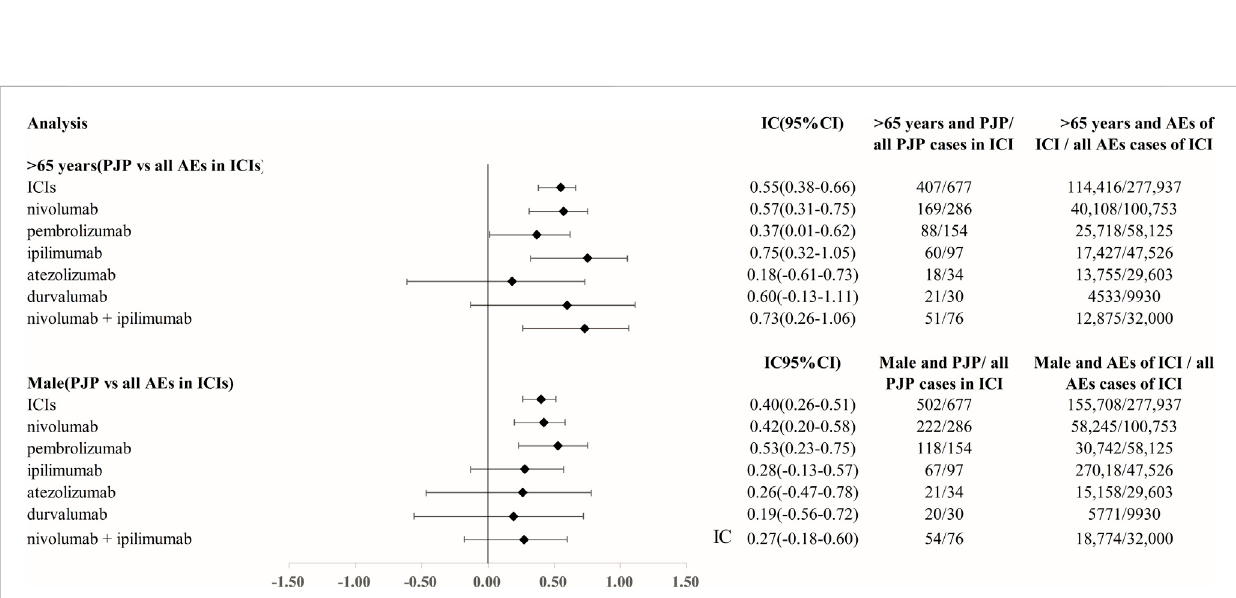
FIGURE 3 Age and gender distribution in Pneumocystis jirovecii pneumonia signal cases of ICIs. Abbreviation: PJP, Pneumocystis jirovecii pneumonia. ROR, reporting odds ratio. IC, information component. 95%CI, 95% con fi dence interval. N, number. AEs, adverse events. ICIs, immune checkpoint inhibitors.